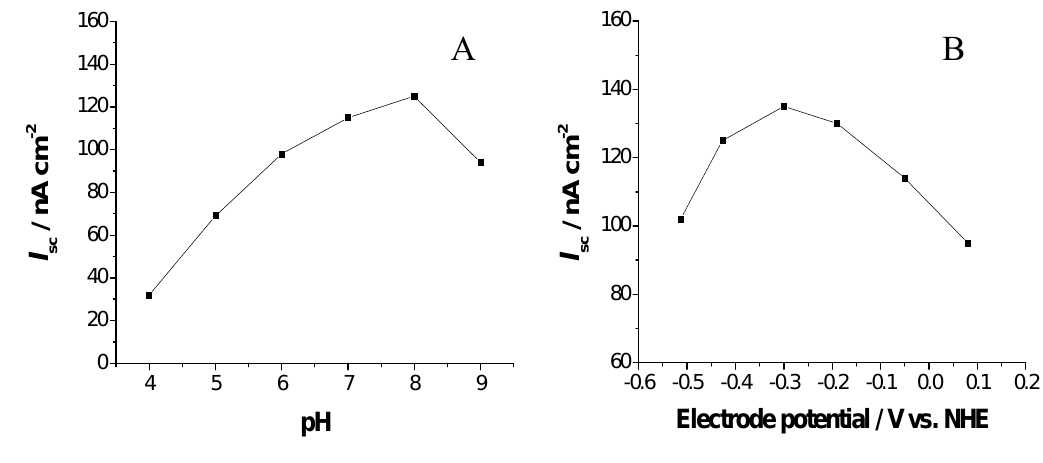
Figure 5. The effects of pH and electrode potential on the photocurrent responses for the TiO /RC film at the wavelength of incident light Κ > 600 nm (I 2 (A) Relationship between the I (B) Relationship between the I